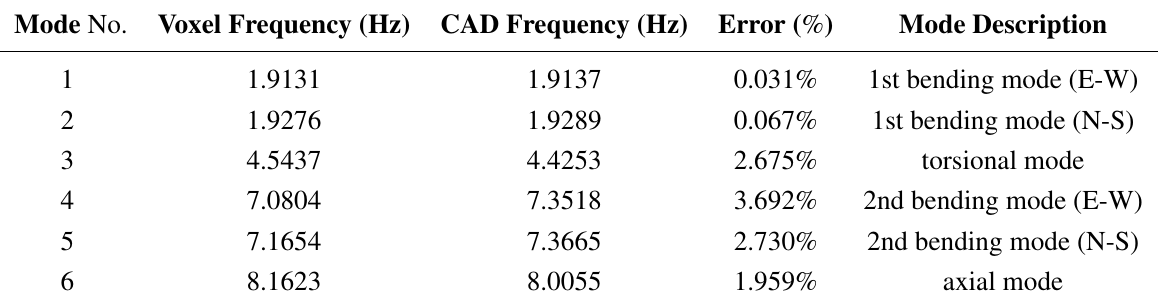
Table 3. Natural frequencies’ analysis: frequencies of the main mode shapes of the Mastio tower of the San Felice sul Panaro Fortress. Comparison between the voxel-based model and the CAD-based model.